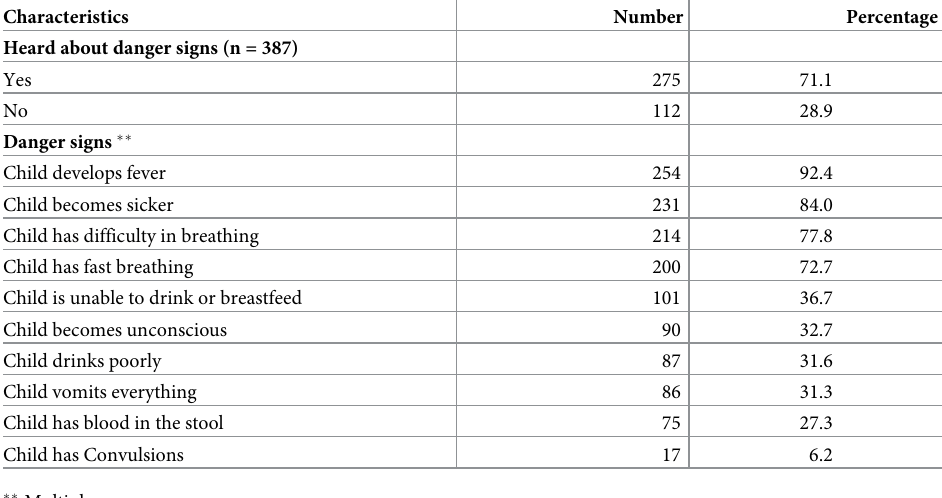
Table 4. Distribution of caretakers according to knowledge on danger signs of childhood